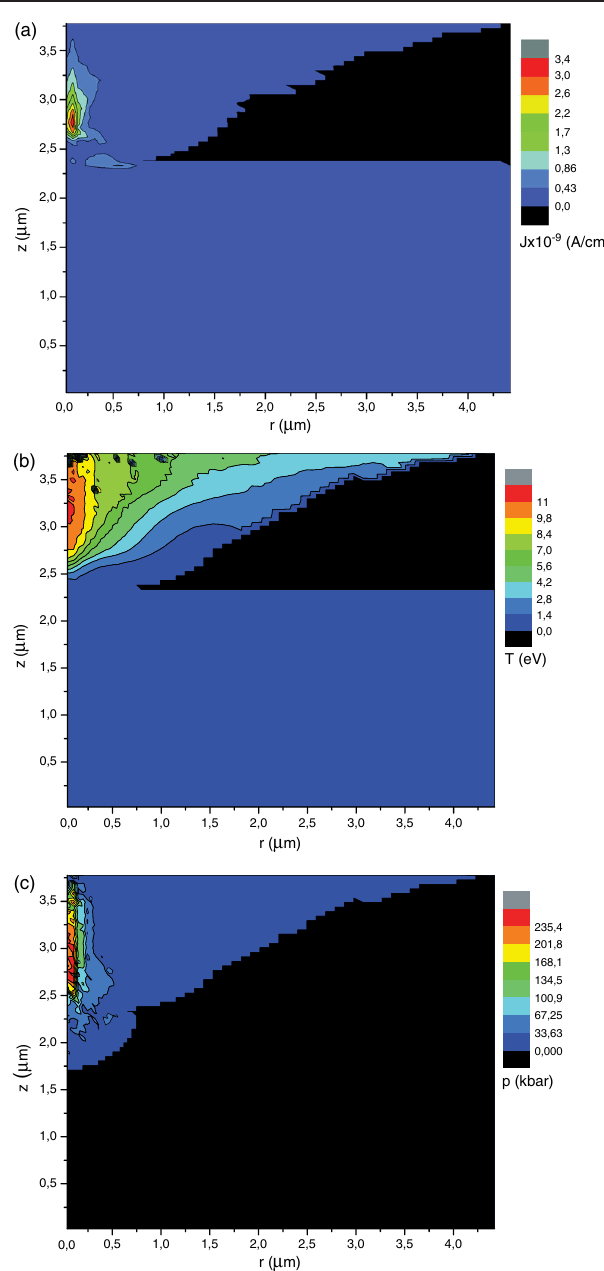
FIG. 4. Current density (a), temperature (b), and pressure distributions (c) at t ¼ 3